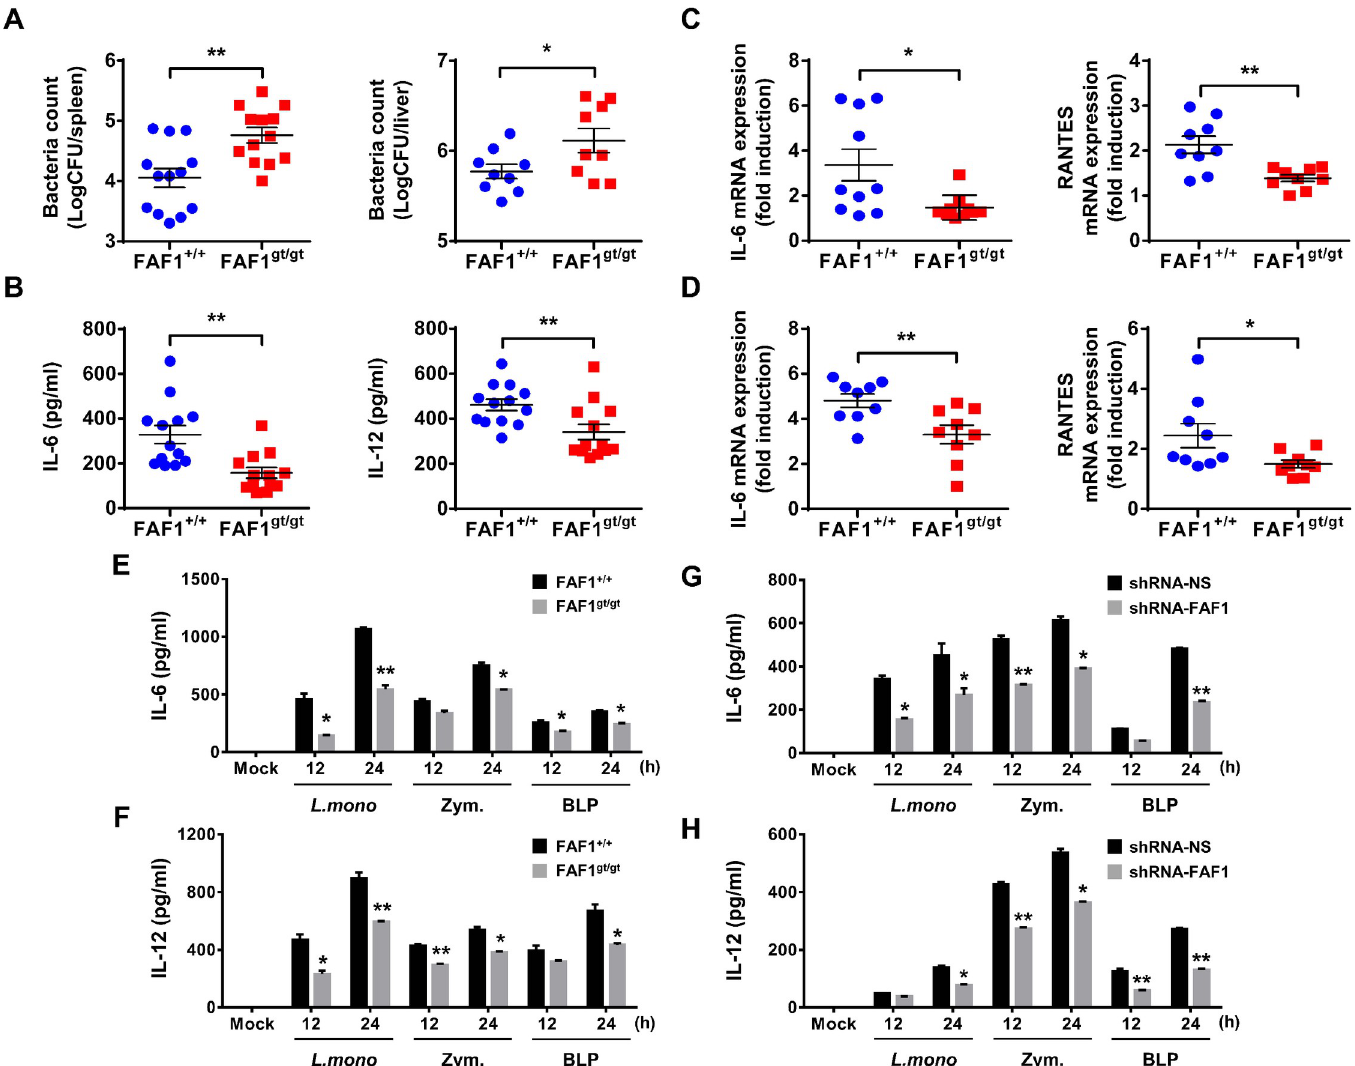
Fig 1. FAF1 functions as a positive regulator of antibacterial immunity in vivo and in vitro . (A-D) FAF1 +/+ and FAF1 gt/gt mice were infected intraperitoneally with L . monocytogenes (5.0 × 10 5 CFU/mouse). The bacterial load in spleens and livers from infected mice (A), serum cytokine levels (B), mRNA levels for cytokines in spleens (C) and livers (D) were measured at 24hr post-infection (n = 9–13 per group). � P < 0.05, �� P < 0.01 (Mann-Whitney test). Data are the mean ± SEM of individual values pooled from two independent experiments. (E and F) FAF1 +/+ and FAF1 gt/gt BMDMs were infected with L . monocytogenes (MOI = 1) for 2hrs or treated with BLP (100ng/ ml) or zymosan (100 μ g/ml) for the indicated times and the supernatants were analyzed for levels of IL-6 (E), IL-12 (F). (G and H) Control Raw264.7 cells (shRNA-NS) and FAF1 knockdown Raw264.7 cells (shRNA-FAF1) were infected with L . monocytogenes (MOI = 1) for 2hrs or treated with BLP (100ng/ml) or zymosan (100 μ g/ml) for the indicated times and the supernatants were analyzed for levels of IL-6 (G), IL-12 (H). Data are representative of three (E-H) independent experiments. Error bars, mean ± SD. � P < 0.05, �� P < 0.01 (Student‘s t -test), compared to FAF1 +/+ .